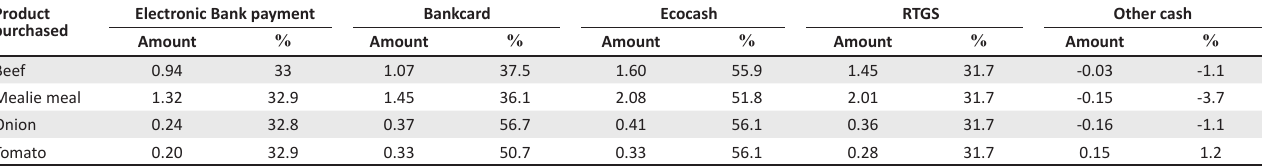
TABLE 2: Cost differential in cash United States dollar prices. † Product